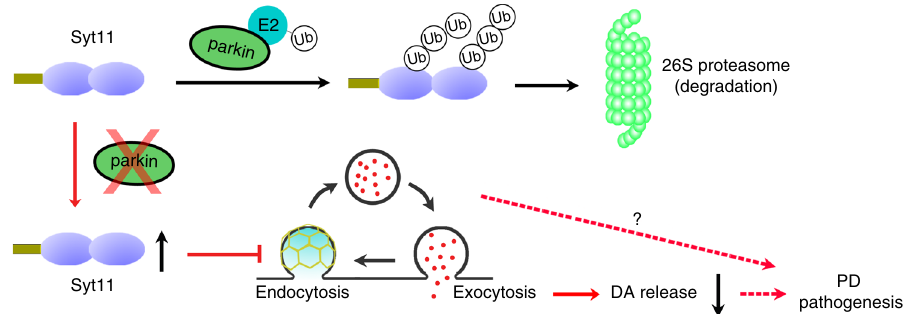
Fig. 9 Schematic model showing the role of Syt11 in parkin-associated PD. The E3 ligase parkin mediates the ubiquitination and proteasome-dependent degradation of Syt11, whereas parkin dysfunction induced by genetic mutations or environmental factors leads to the accumulation of Syt11 in midbrain DA neurons. This inhibits endocytosis and the following processes of vesicle replenishment, which then lead to the impairment of DA release and most probably the initiation of